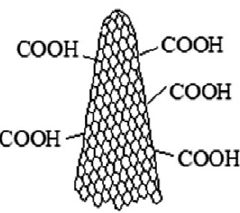
Figure 2. The structure of oxidized SWCNHs.